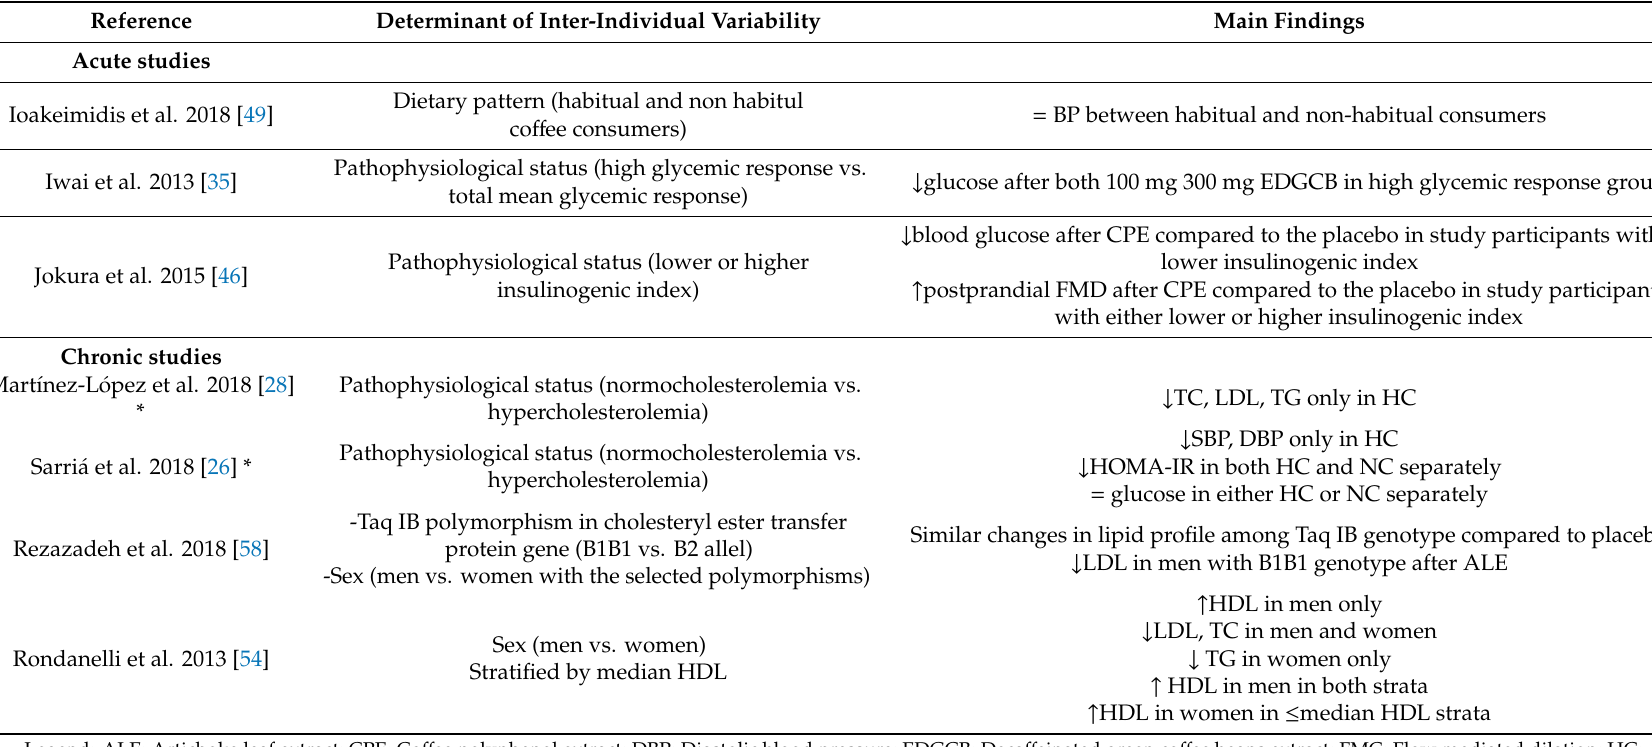
Table 3. Main findings of studies investigating the e ff ect of HCA-rich foods on cardiometabolic markers and considering determinants of inter-individual